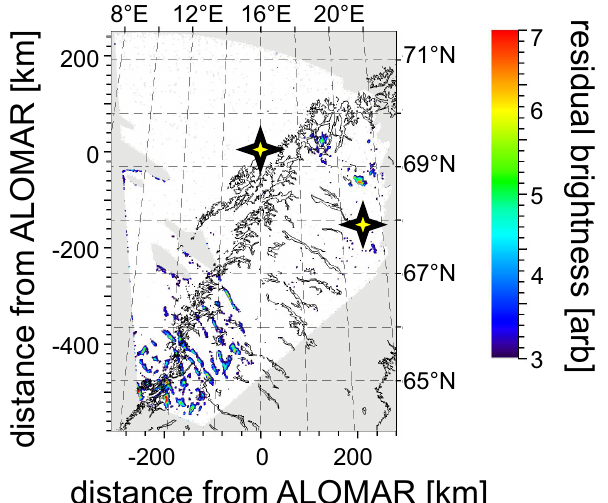
Fig. 9. Residual sky brightness observed from Trondheim on 3 Au- gust 2007 22:17UT with enhanced NLC structures. A detailed de- scription of the structure enhancement is given in the text. ALO- MAR and the Esrange are marked by black symbols.